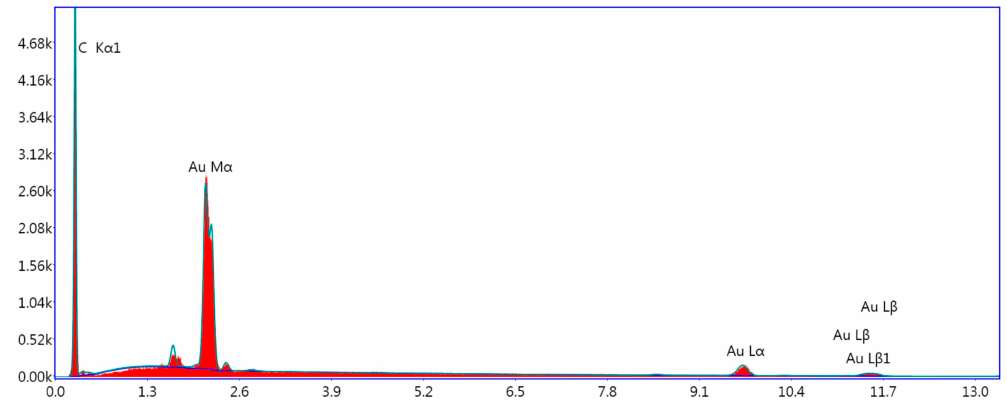
Figure 3. Energy dispersive X-ray EDX spectrum of the AuNPs/Gr nanocomposites.